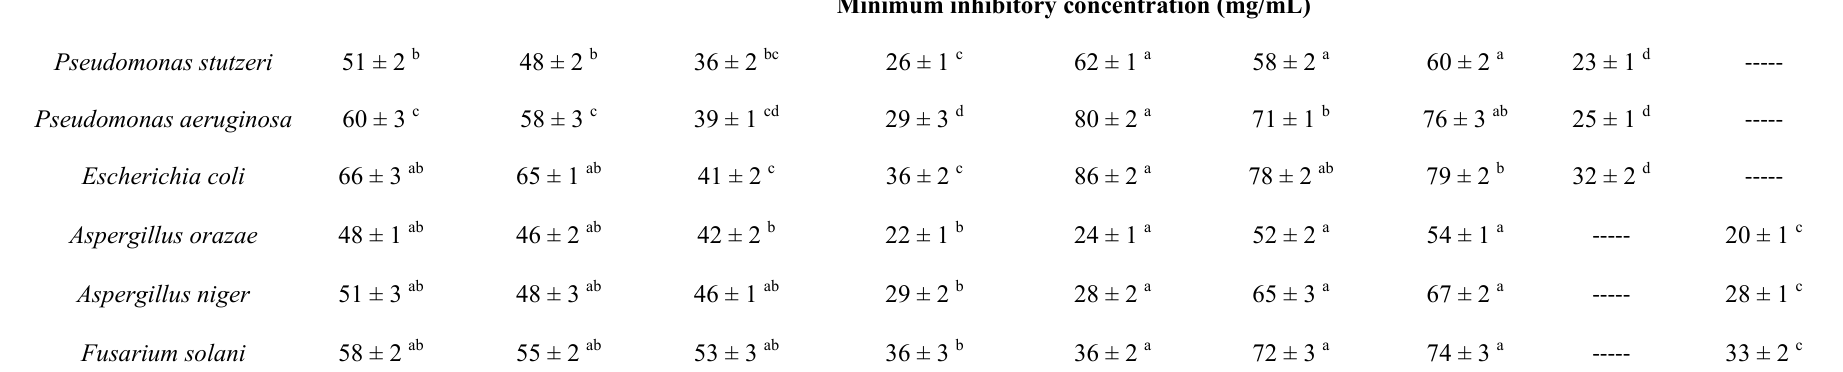
Values are mean ± SD of three separate experiments. Different superscript letters within the same row indicate significant ( p < 0.05) differences of means within the extracting